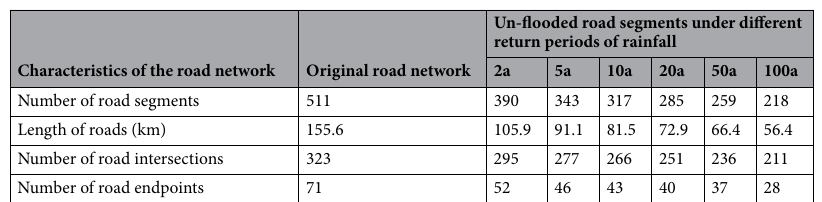
Table 3. Changes in road network characteristics across various rainfall scenarios.